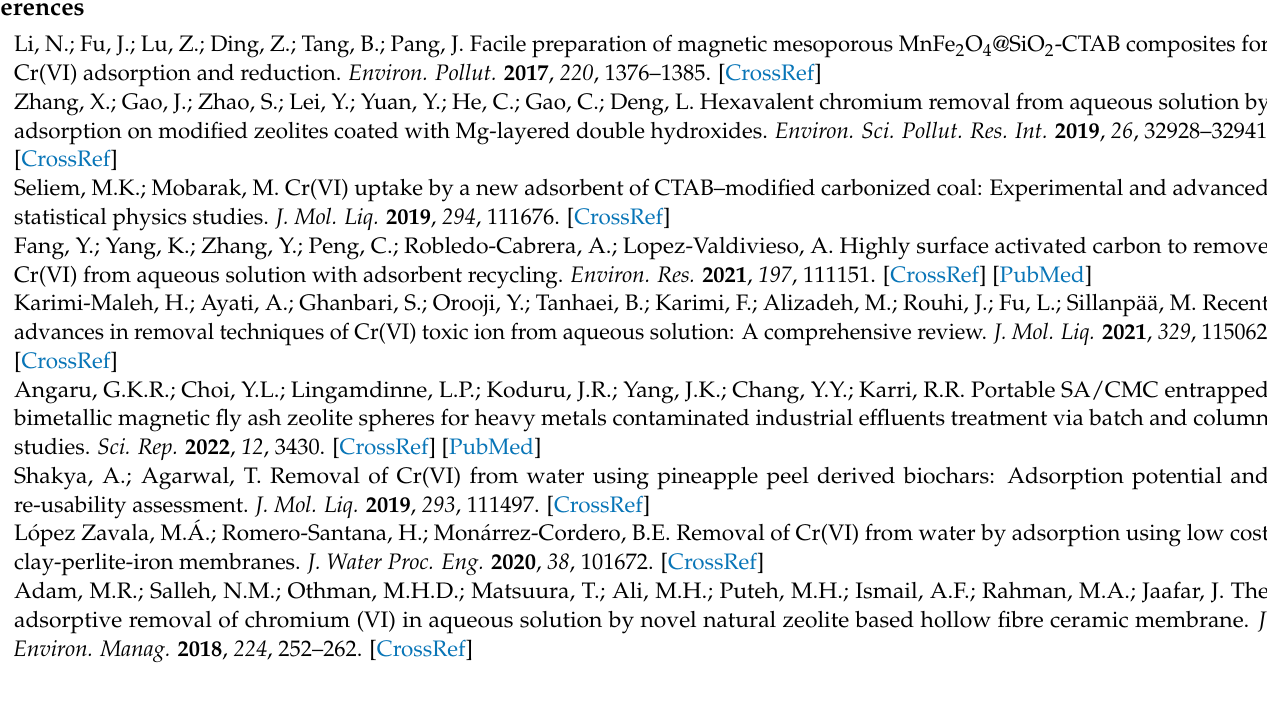
Figure S2: (a) Effect of temperature on Cr(VI) removal; (b) Adsorption thermodynamics; Details of isotherms, kinetics, and thermodynamic modeling